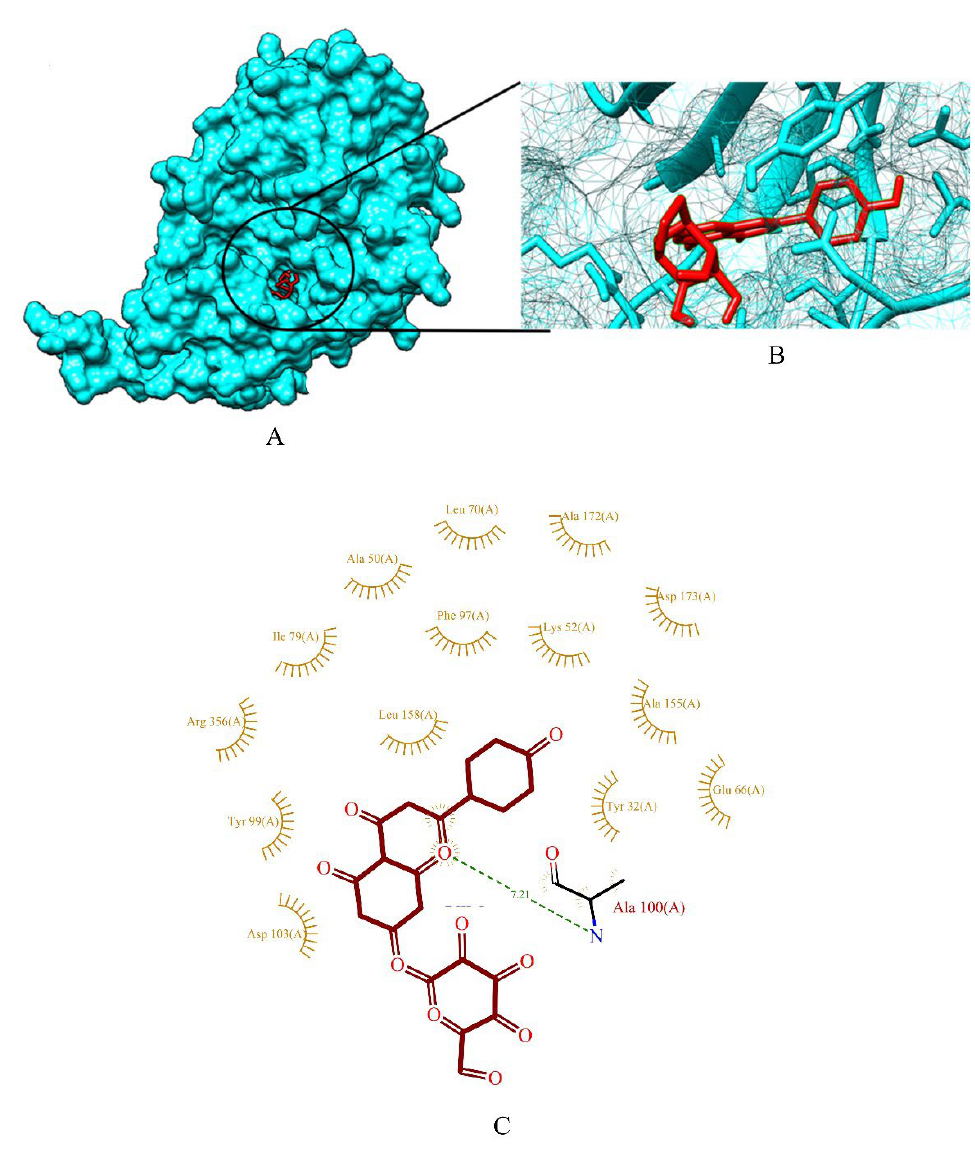
Figure 3. ( A ) Surface view of apigetrin-CDK8 binding complex. ( B ) Binding pose of apigetrin. ( C ) Visualization of the docked complex with ligplot + shows the binding interaction of apigetrin with CDK8. One hydrogen bond interaction (green dotted line) was formed between apigetrin and one amino acid residue (Ala 100) of target protein of CDK8.